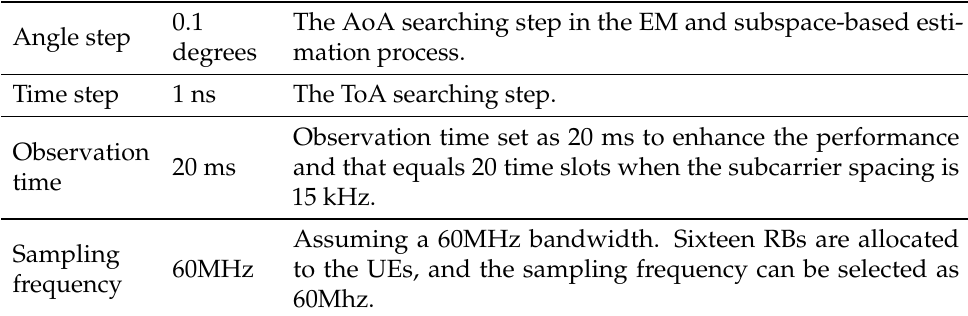
Table 3. Positioning algorithms’ parameters.